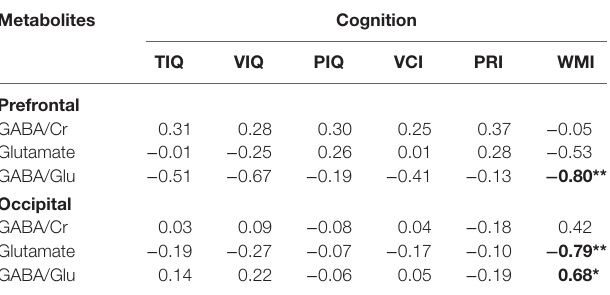
Bold font indicates significant correlations. a Pearson correlations, corrected for age, sex, and for local gray matter and white matter fractions. **p ≤ 0.01.